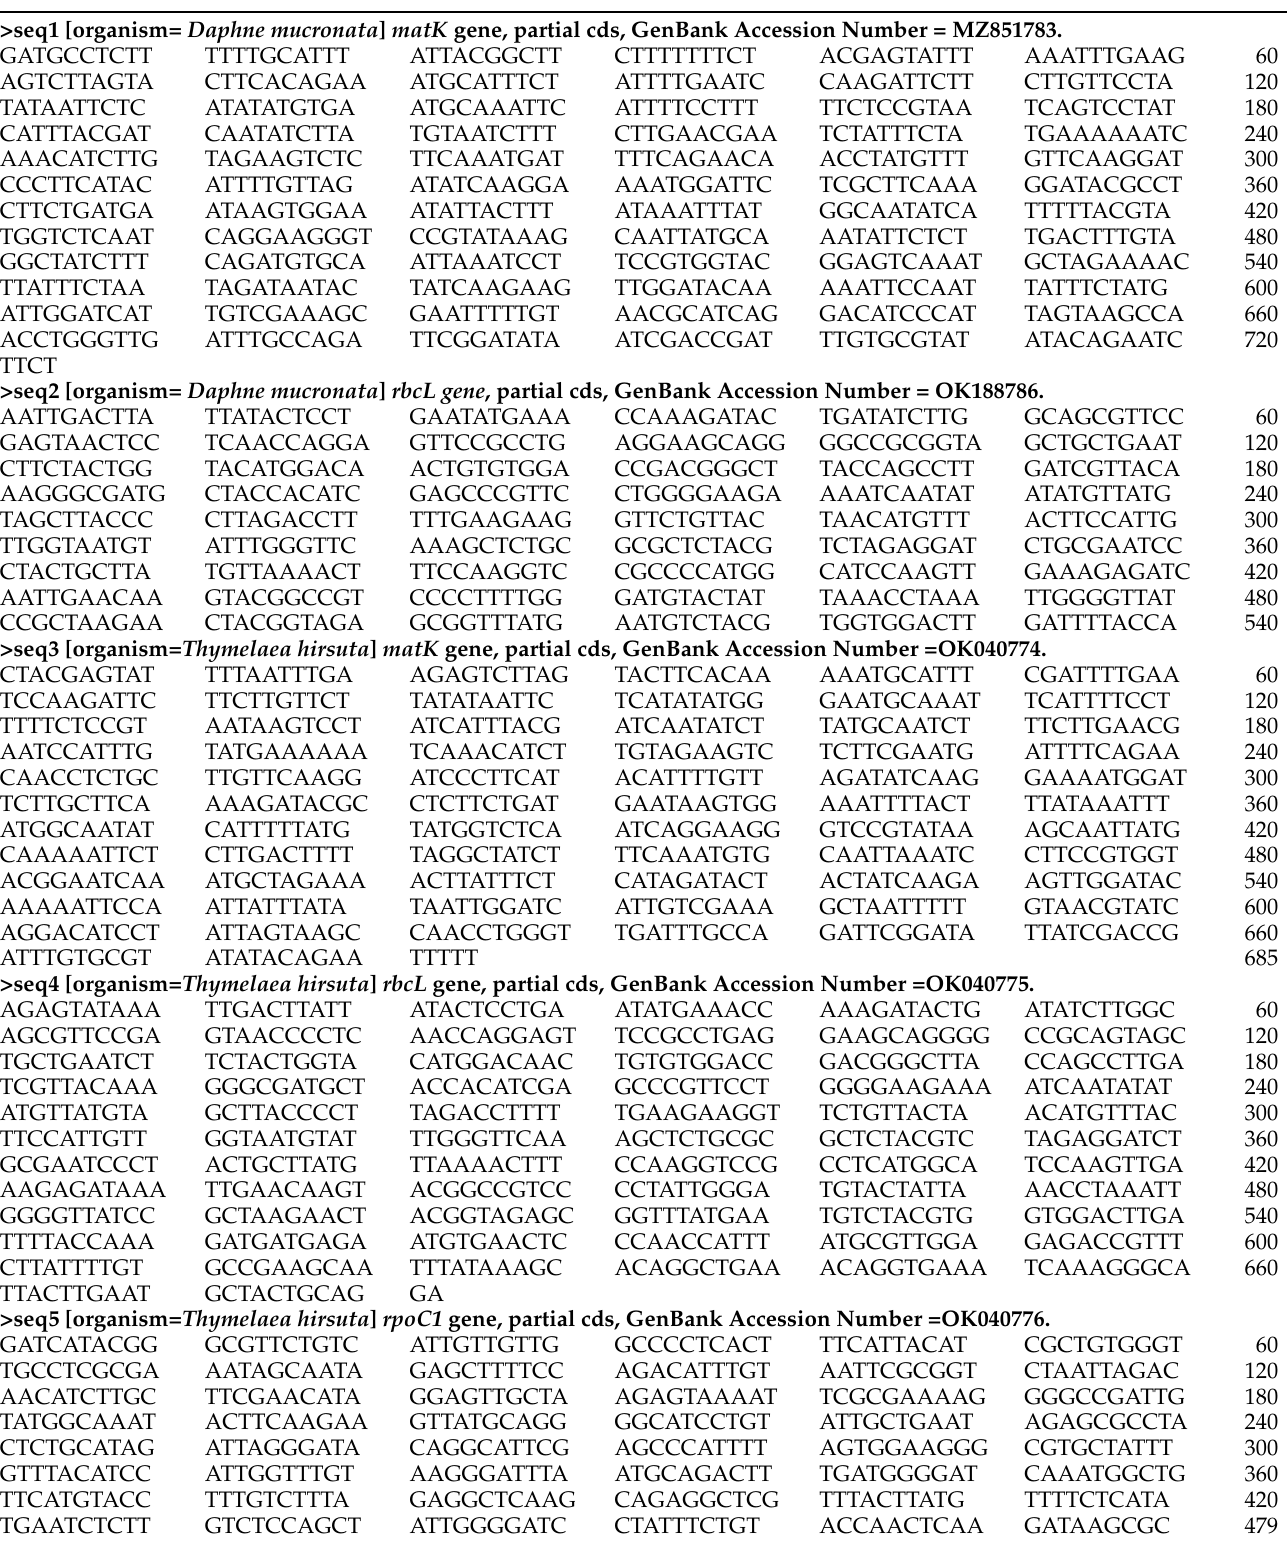
Table A1. List of obtained plant samples sequences in FASTA